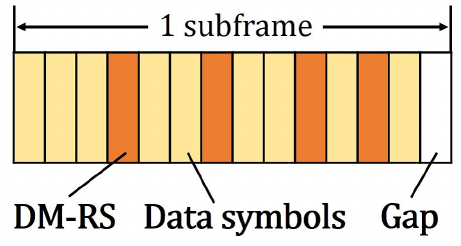
Figure 4. Subframe structure for sidelink for Release